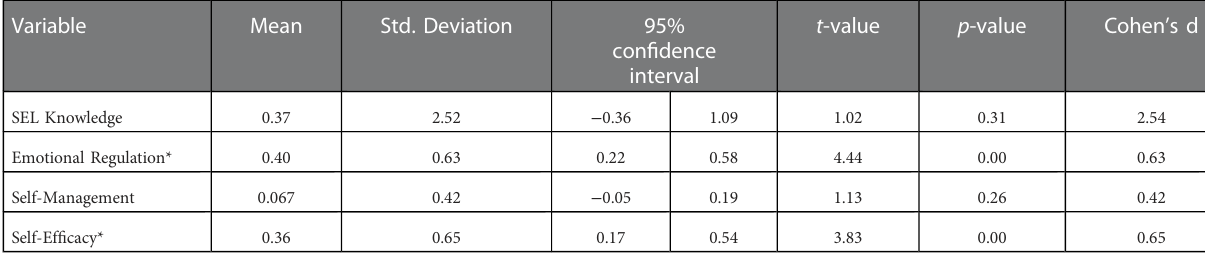
*Indicates statistical signi fi cance at p